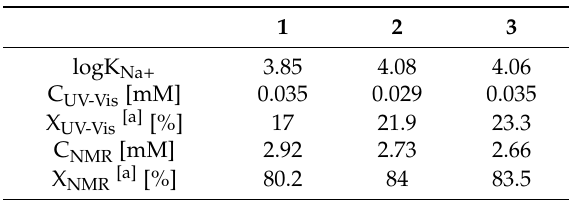
Table 3. Association constants (log K a ) for the interaction between receptors 1 – 3 and NaClO 4 and calculated % fraction of receptor occupied by the sodium cation under UV-vis and 1 H NMR titration conditions.